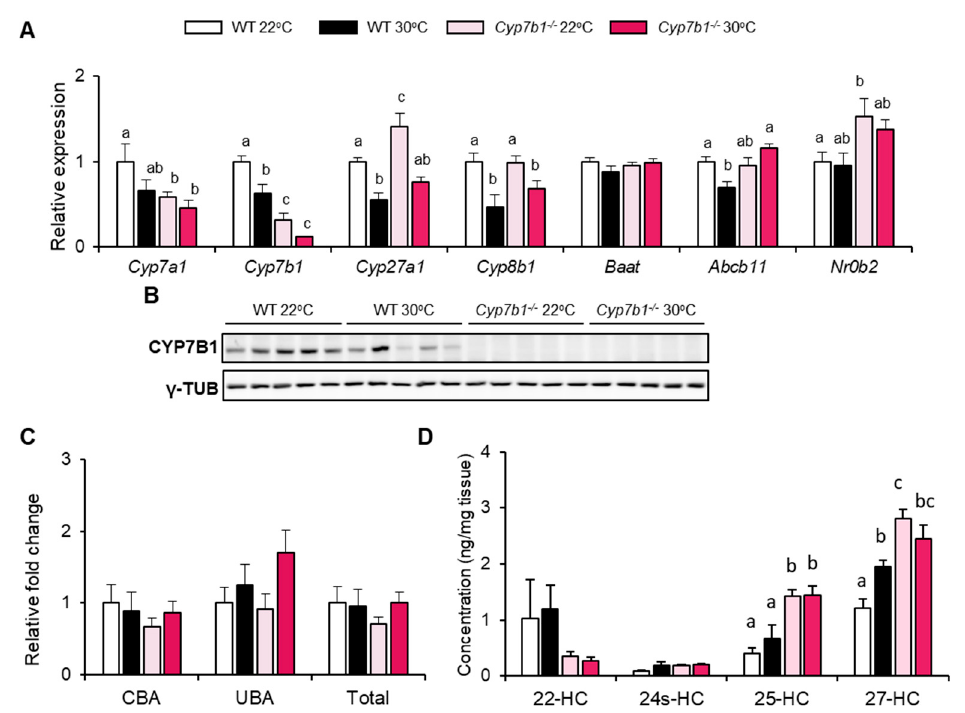
Figure 4. Influence of CYP7B1-deficiency on bile acid and oxysterol metabolism. Cyp7b1 − / − and WT littermates were housed at 22 ◦ C or 30 ◦ C and fed a CD-HFD for 8 months. ( A ) Relative hepatic expression of bile acid- and oxysterol-related genes (n = 8). ( B ) Western blot analysis of hepatic CYP7B1 and the loading control gamma tubulin ( γ -TUB). ( C ) Relative change of portal bile acid levels in comparison to WT 22 ◦ C mice (number of mice: WT 22 ◦ C: n = 11; WT 30 ◦ C: n = 9; Cyp7b1 − / − 22 ◦ C: n = 16; Cyp7b1 − / − 30 ◦ C: n = 13). ( D ) Levels of hepatic hydroxycholesterol species (n = 8). Data are shown as mean values ± SEM. Different letters indicate significant differences between groups ( p < 0.05) determined by two-way ANOVA.